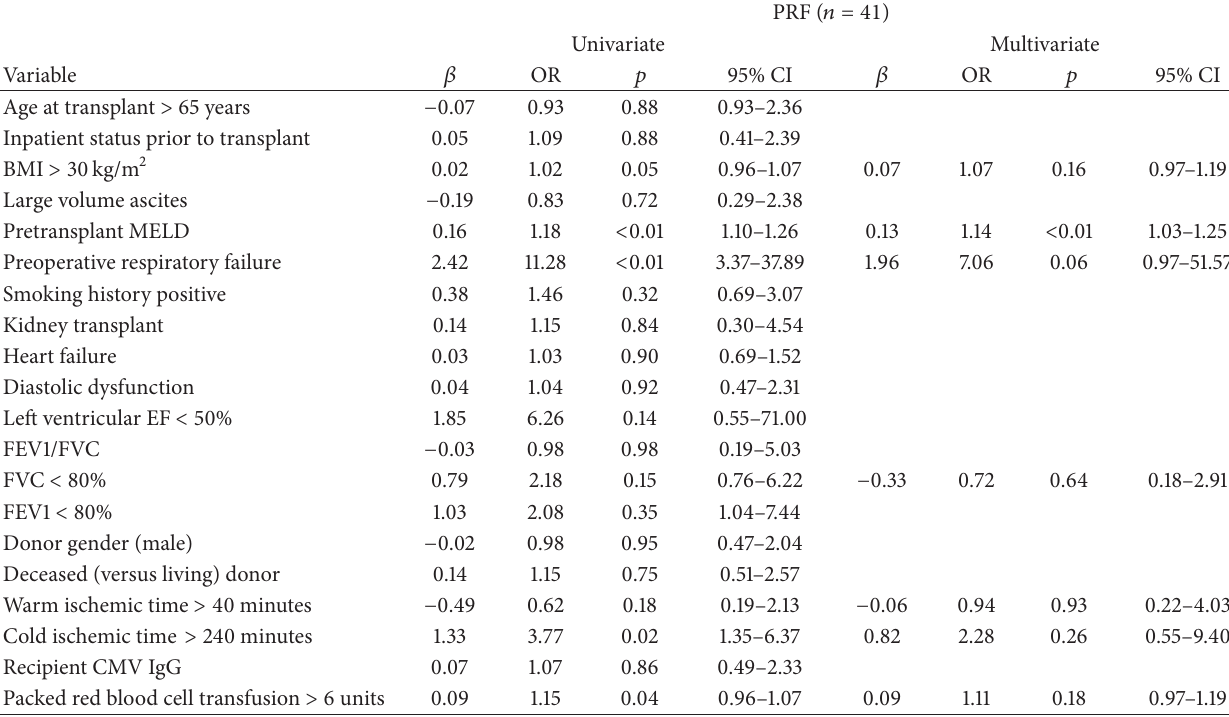
Table 2: Univariate and multivariate analysis of PRF.